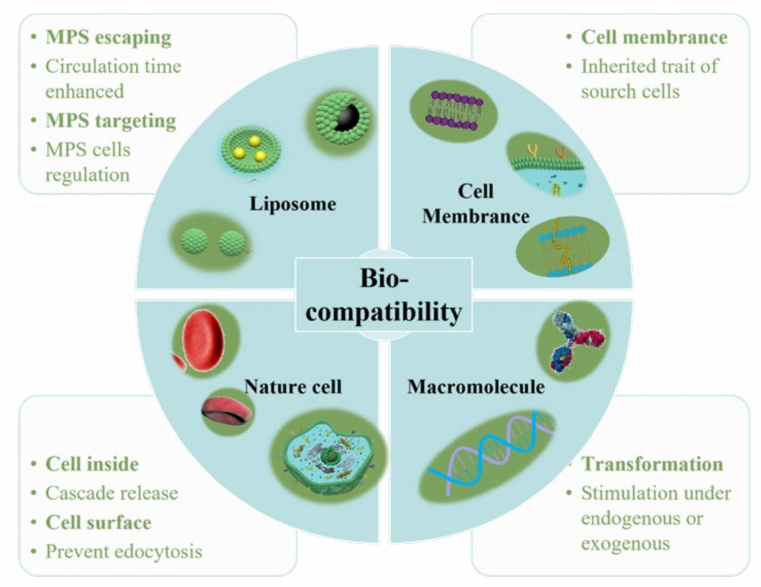
Figure 1. Methods for increasing the biocompatibility of micro-nano